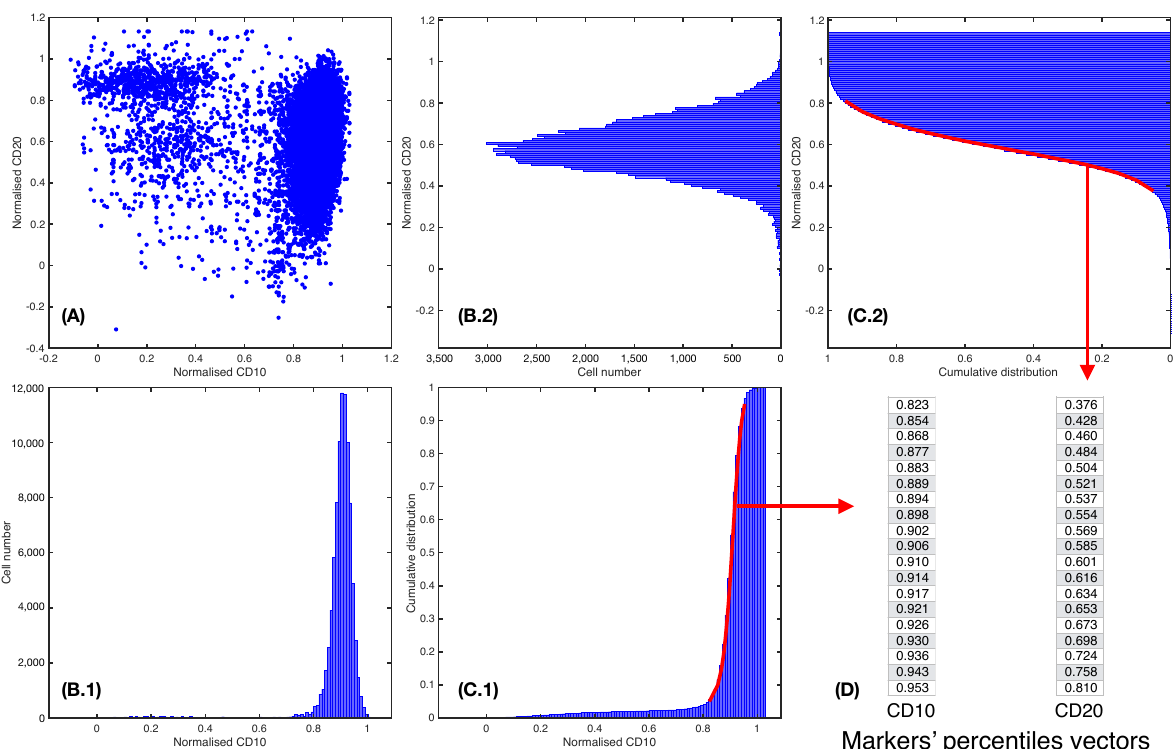
Figure 2. Percentile vector construction. ( A ) Scatter plot of a patient i for two normalised parameters, j 1 = CD10 and j 2 = CD20. ( B.1 ) and ( B.2 ). Histograms cell count of, respectively, j 1 = CD10 and j 2 = CD20. ( C.1 ) and ( C.2 ). Cumulative distribution of markers j 1 = CD10 and j 2 = CD20, respectively. In red, percentiles curve from 5th to 95th percentile. ( D ) Each percentile curve for each patient i and marker j results in a vector x ij percentiles